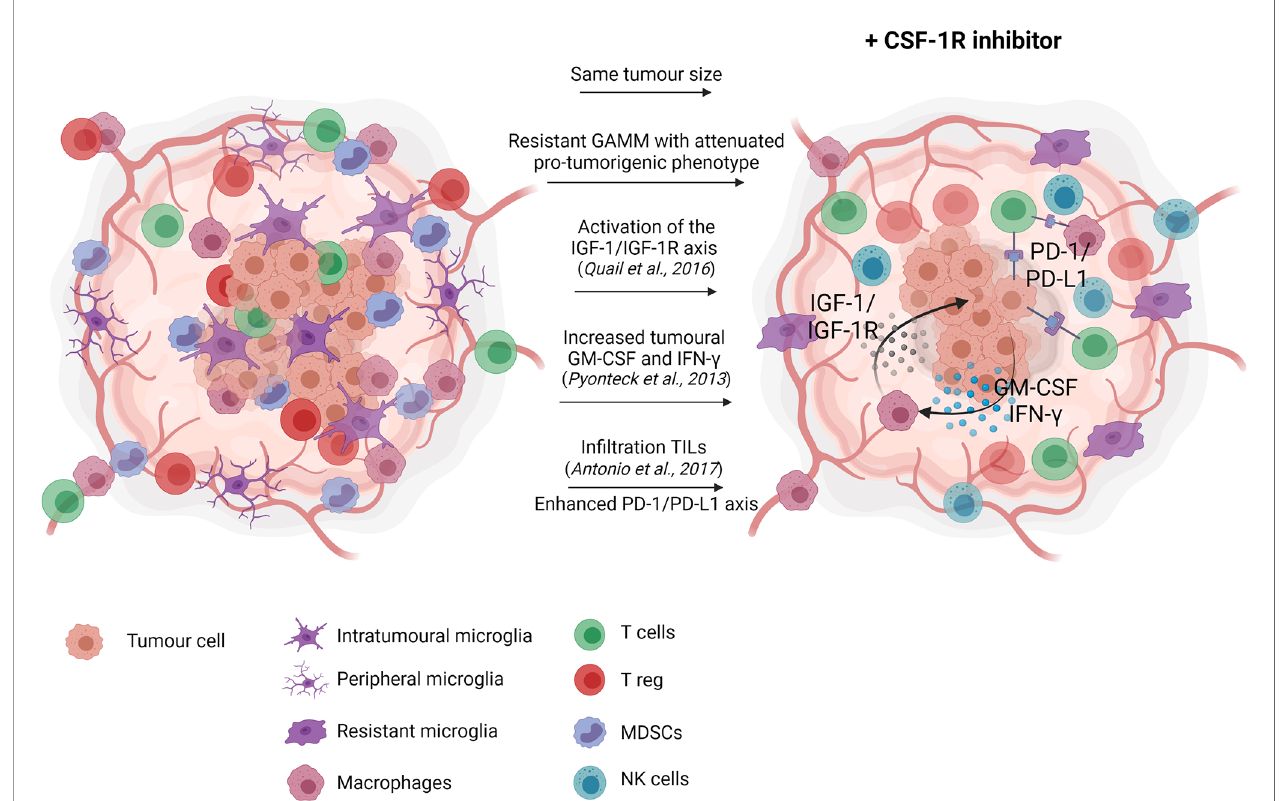
FIGURE 1 | CSF-1R inhibition monotherapy in glioma. In glioma models, CSF-1R inhibition delays recurrence, and therefore slightly prolong overall survival with no signi fi cant effect on tumour growth. Reported resistance mechanisms to CSF-1R inhibition include increased insulin-like growth factor (IGF-1) signaling between macrophages and tumor cells, ultimately promoting tumor cell survival and invasion (77), increased levels of granulocyte-macrophage (GM)-CSF and interferon (IFN)- g , leading to TAM persistence (66) and increased tumor-associated lymphocytes in fi ltration favoring the immunosuppressive PD-1/PD-L1 signaling (78). Created with